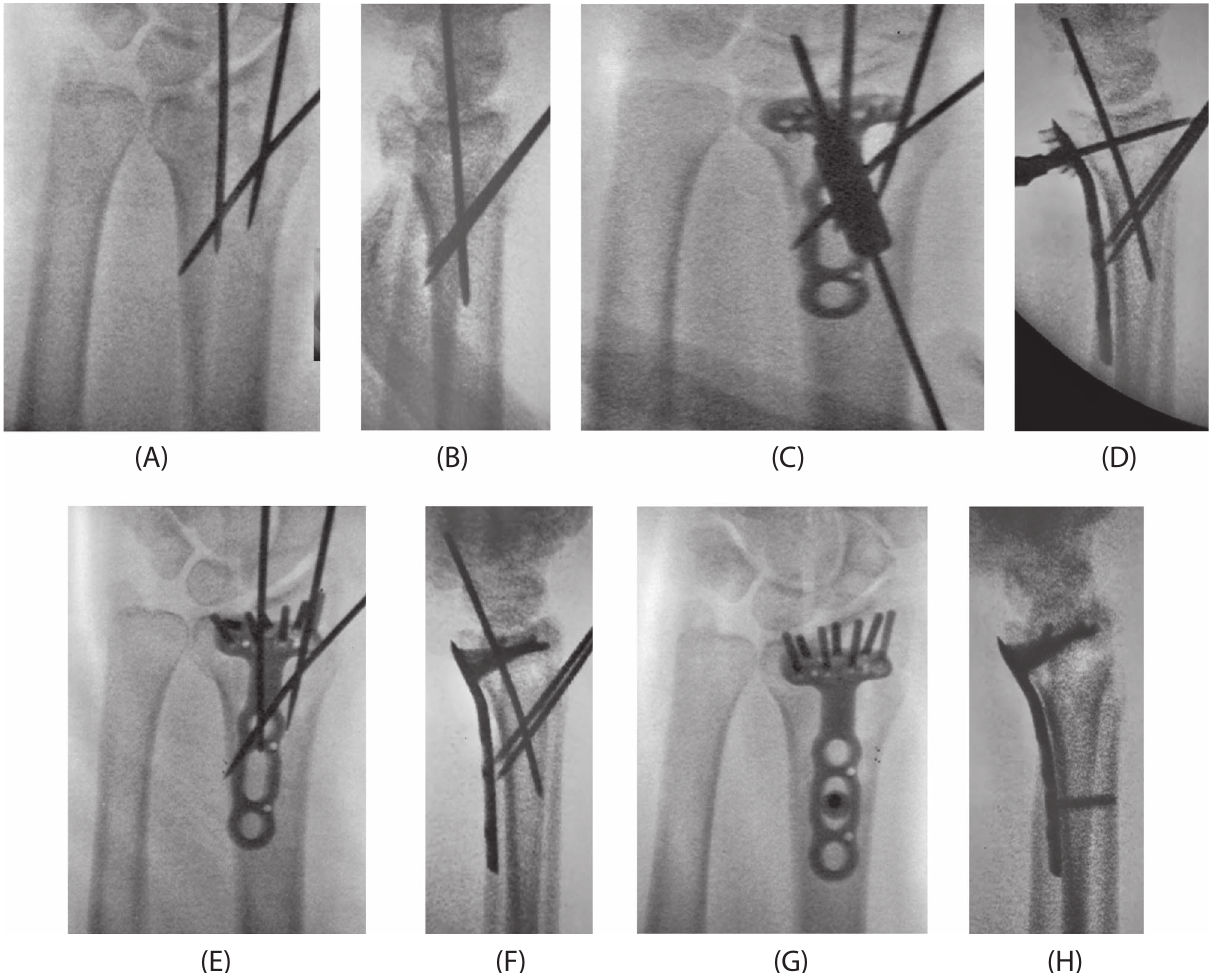
Figure 1. Surgical procedure for distal radius fractures with dorsal-displaced VLFF. From the dorsal side of the fracture region, 1.8-mm Kirschner wire was inserted and dorsal displacement of distal bone fragments was reduced using the Kapandji technique ((A) PA view, (B) Lateral view). Dorsal volar bone fragments were pressed to each other to be bound to reduce the gap in the fracture region ((C) PA view, (D) Lateral view). The plate was placed at a position at which distal locking screws support the dorsal side of the radial joint surface ((E) PA view, (F) Lateral view). The distal bone fragment was reduced and fi xed according to the condylar stabilizing method ((G) PA view, (H) Lateral